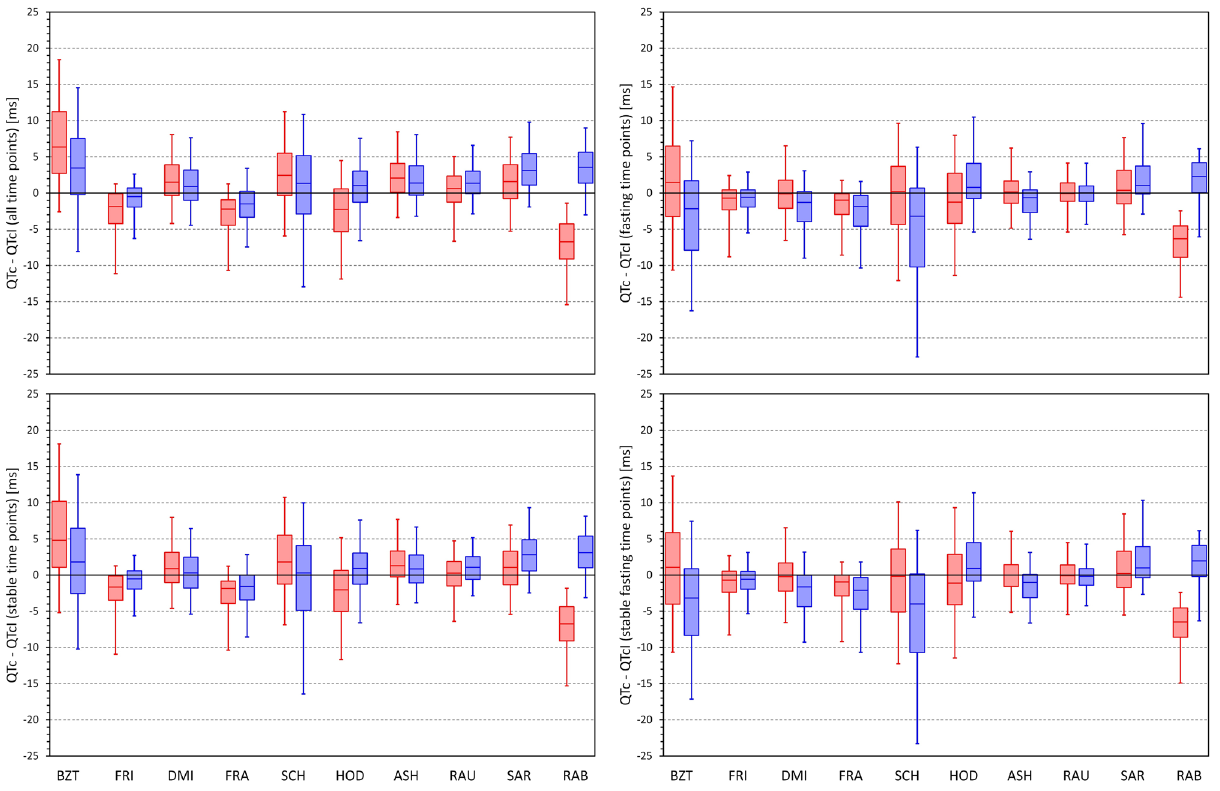
Figure 12. Distribution of the mean intra-subject differences between QTc intervals by different correction formulas and the corresponding QTcI values. The distribution of the differences is shown for calculations over all study time-points (top left panel), time-points with stable heart rate (bottom left panel), morning fasting time-points (top right panel), and morning fasting time-points with stable heart rate (bottom right panel). The layout of the panels and the meaning of the box and whisker graphs is the same as in Fig. 8. ms